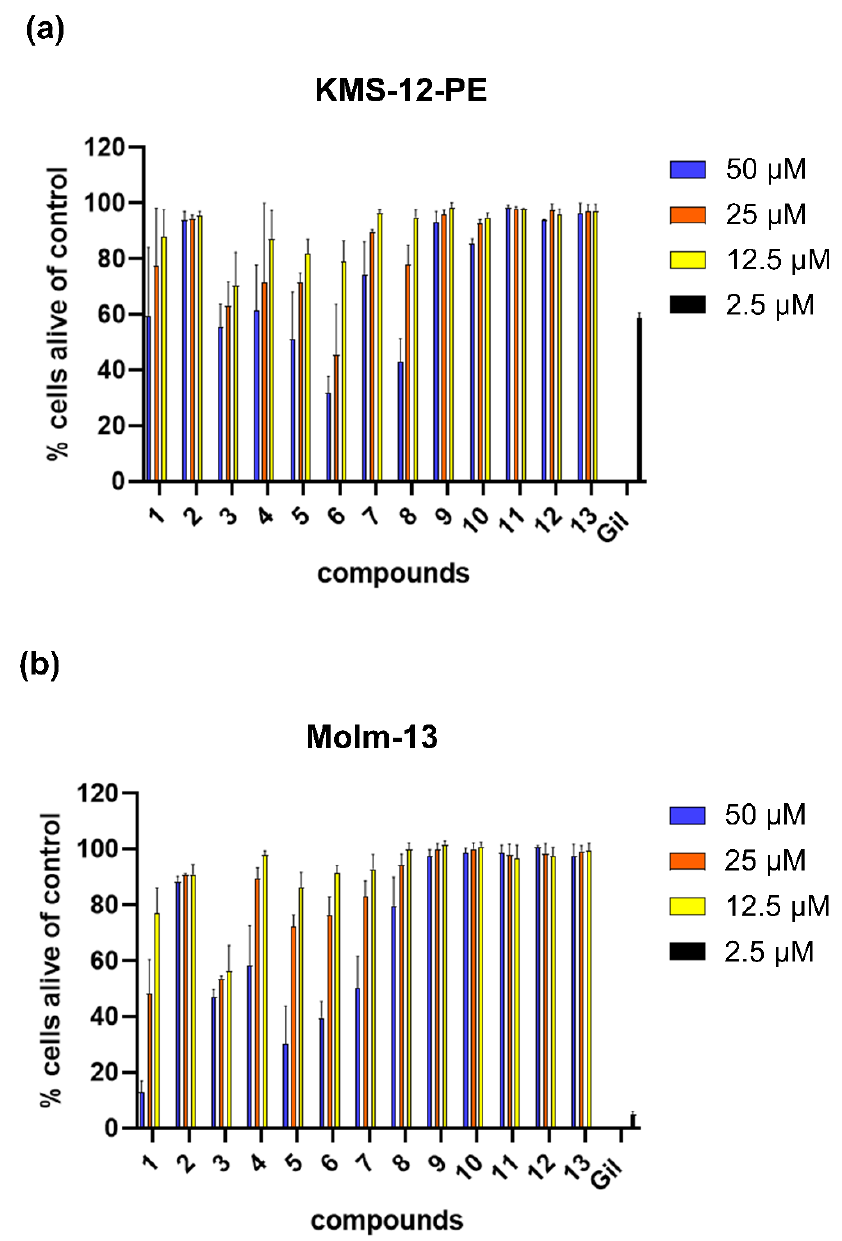
Figure 2. Apoptosis of cancer cells after treatment with isolated compounds. Percentage of cells alive after treatment with compounds 1 to 13 : ( a ) KMS-12-PE and ( b ) Molm-13 cells were treated with indicated concentrations (50 µ M/25 µ M/12.5 µ M) of compounds for 48 h. Gilteritinib (2.5 µ M) was used as positive control. Cell survival was measured by calculating cells which did not stain with AnnexinV/PI in comparison to untreated controls. Mean +/ − SD of 2–4 independent experiments in duplicates are shown.